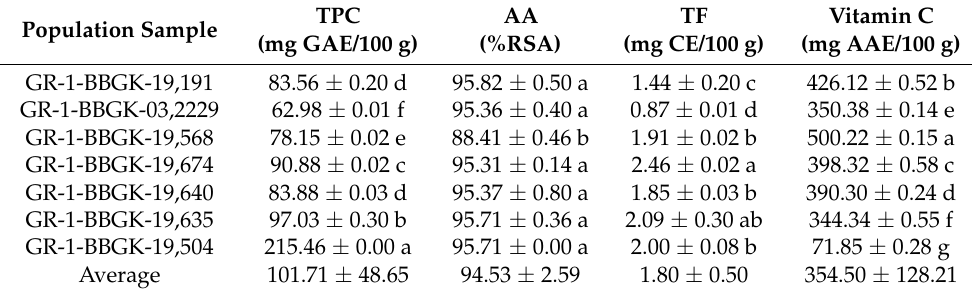
Table 1. Values of total phenolic content (TPC), antioxidant activity (AA), total flavonoids (TF) and Vitamin C content detected in samples of wild-growing genotypes of Rosa canina of northern